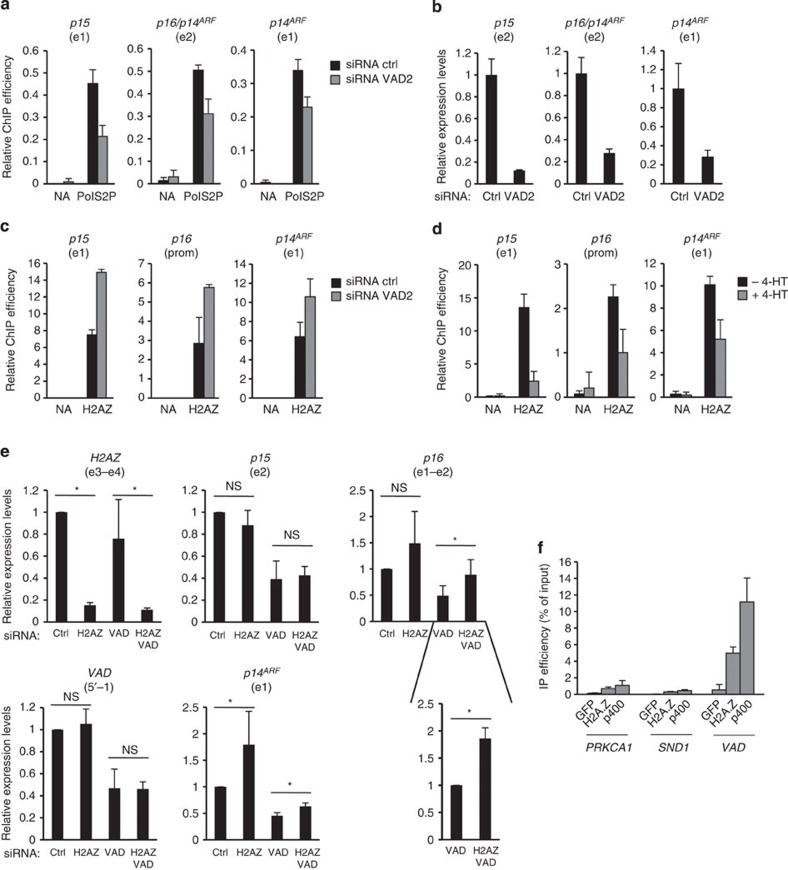
VAD prevents the H2A.Z-mediated repression of INK4 promoters.(a) Senescent WI38 hTERT RAF1-ER cells were transfected by VAD siRNA and subjected to a RNA PolII phospho S2 (PolS2P) ChIP. The presence of p15 and p14ARF first exons and p16/p14ARF second exon were tested by qPCR. A representative experiment out of two is shown (mean and s.d. from the qPCR sample triplicates). The amount of the indicated sequences was calculated relative to the input DNA and the enrichment for each indicated sequence was normalized to the enrichment of a control sequence (GAPDH exon 1). Note that given that all sequences transcribed to produce p16 are also contained within p14ARF, we cannot assess the presence of RNA PolII phospho S2 on p16 specifically. (b) Same as in a, except that a nuclear run-on was performed. A representative experiment out of two is shown (relative to GAPDH and normalized to 1 in siRNA control cells, mean and s.d. from the qPCR sample triplicates). (c) Same as in a, except that cells are subjected to a ChIP assay using antibodies against H2A.Z. The amount of the indicated sequences was then quantified by qPCR and calculated relative to the input DNA and as in Fig. 4c. A representative experiment out of two is shown (mean and s.d. from the qPCR sample triplicates). (d) Same as in c, except that WI38 hTERT RAF1-ER cells were induced to senescence for 72 h, or not, as indicated. One representative experiment out of two is shown (mean and s.d. from the qPCR sample triplicates). (e) Senescent WI38 hTERT RAF1-ER cells were transfected by VAD2 and H2AZ siRNAs as indicated and the expression of the indicated RNAs was analysed by qRT–PCR 72 h later. The mean and s.d. from three independent experiments are shown, relative to GAPDH and normalized to 1 in siRNA control cells. The insert shows the effect of H2A.Z siRNA on p16 mRNA expression in VAD-depleted cells, standardized to 1 for cells transfected with VAD siRNA only. It shows that the effect of the H2A.Z siRNA is highly reproducible in this setting and that the large error bars in these samples in the whole panel reflect variations in the effects of VAD depletion from one experiment to the other. The star indicates significant effects of H2A.Z siRNAs (P value<0.05, one-sided unpaired Student’s t-test if control values were set to 1, one-sided paired Student’s t-test if not). NS, not significant. (f) H2A.Z- or p400-containing complexes were purified by immunoprecipitation from HeLa nuclear extracts and incubated with total RNA purified from senescent WI38 hTERT RAF1-ER cells. Bound RNA and input RNA were then analysed by qPCR for the presence of VAD or the indicated pre-mRNA of similar size. Bound RNA levels were calculated relative to the input RNA levels (% of input).